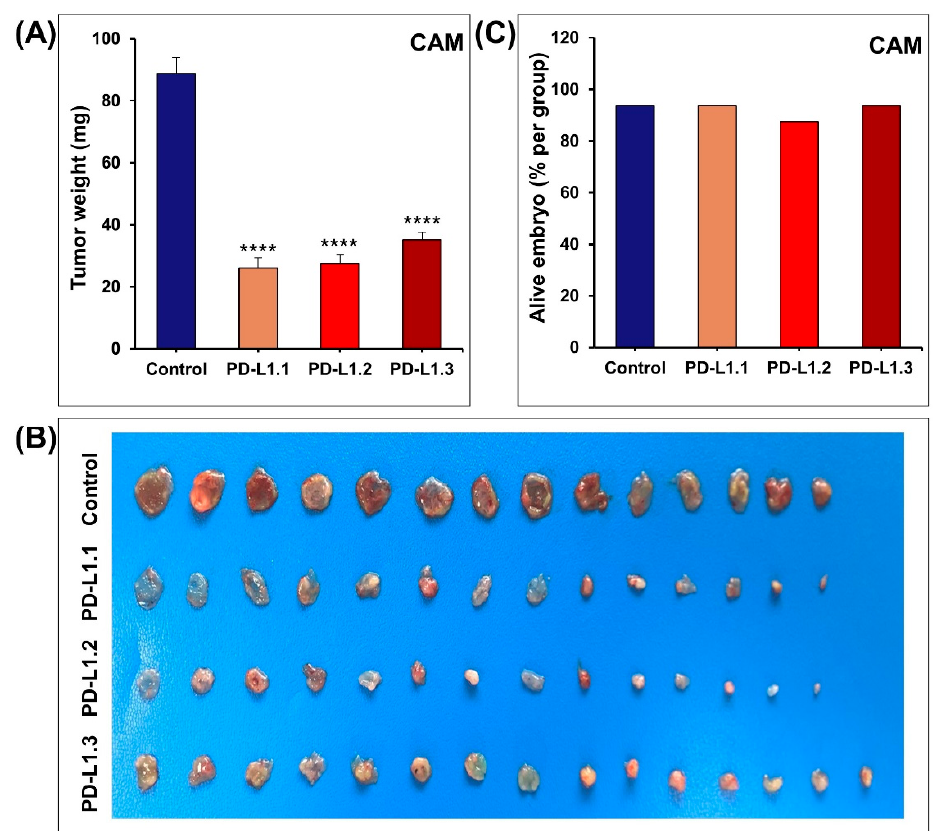
Figure 3. Impact of PD-L1 knockout on tumor growth in chick embryo CAM. ( A ) Tumor weight of the control and PD-L1 knockout cells. The cells were inoculated and allowed to grow on chick embryo CAM for 8 days. ( B ) Pictures of the tumors after extraction on Day 17. ( C ) Percentage of alive embryos in each group. Columns are means; bars are S.E.M. **** p < 0.0001.